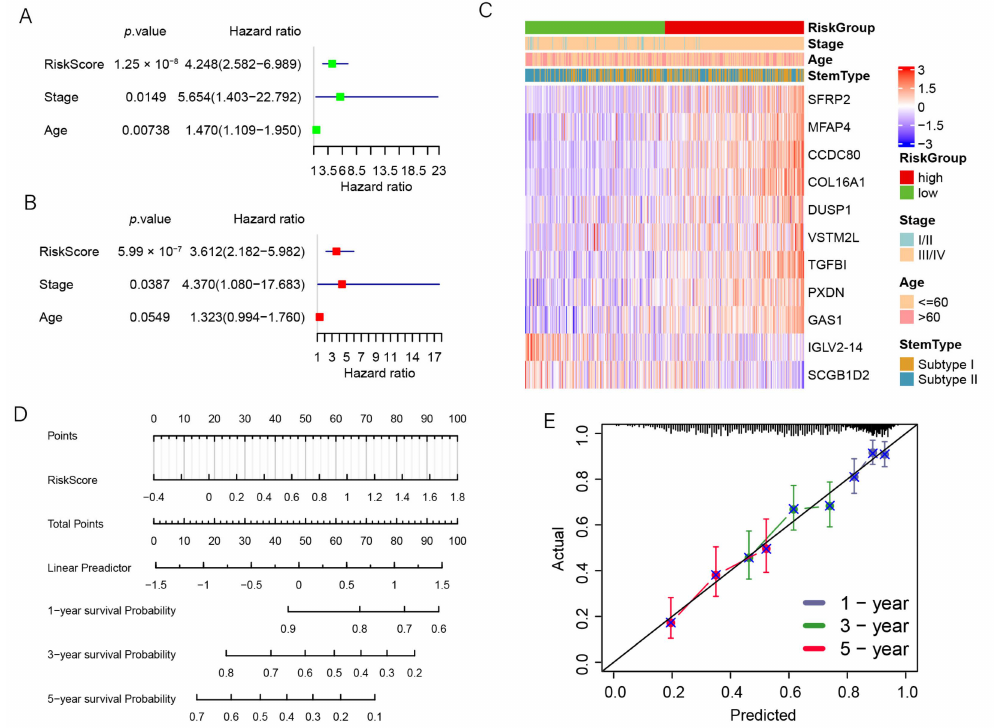
Figure 7. The prognostic signature was an independent prognostic factor. ( A ) The univariate Cox regression analysis. ( B ) The multivariate Cox regression analysis. ( C ) The heatmap for the connections between the clinical characteristics and the risk groups. ( D ) Nomogram of the prediction model for OC. ( E ) The nomogram calibration curves to predict the 1-, 3-, and 5-year